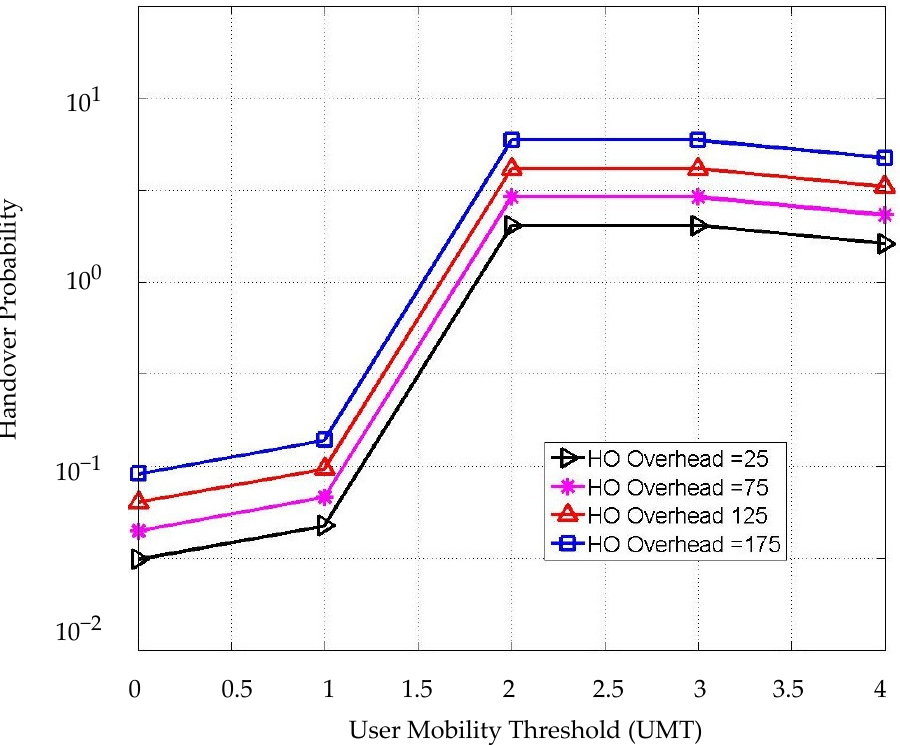
Figure 10. Handover probability with UMT considering different HO overhead values.